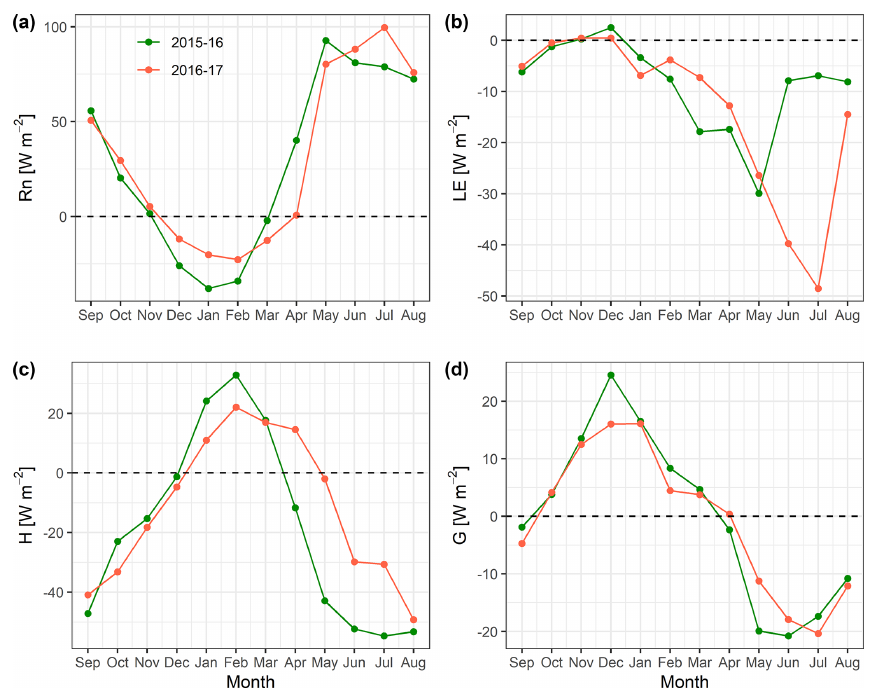
Figure 9. Comparison of estimated mean monthly surface energy balance components (Wm − 2 ) (a) R n , (b) LE, (c) H and (d) G for the